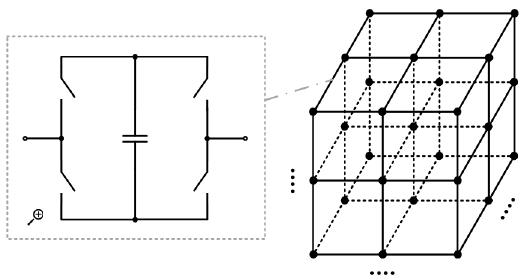
Figure 4. Proposed lattice converter based on the cubic honeycomb.